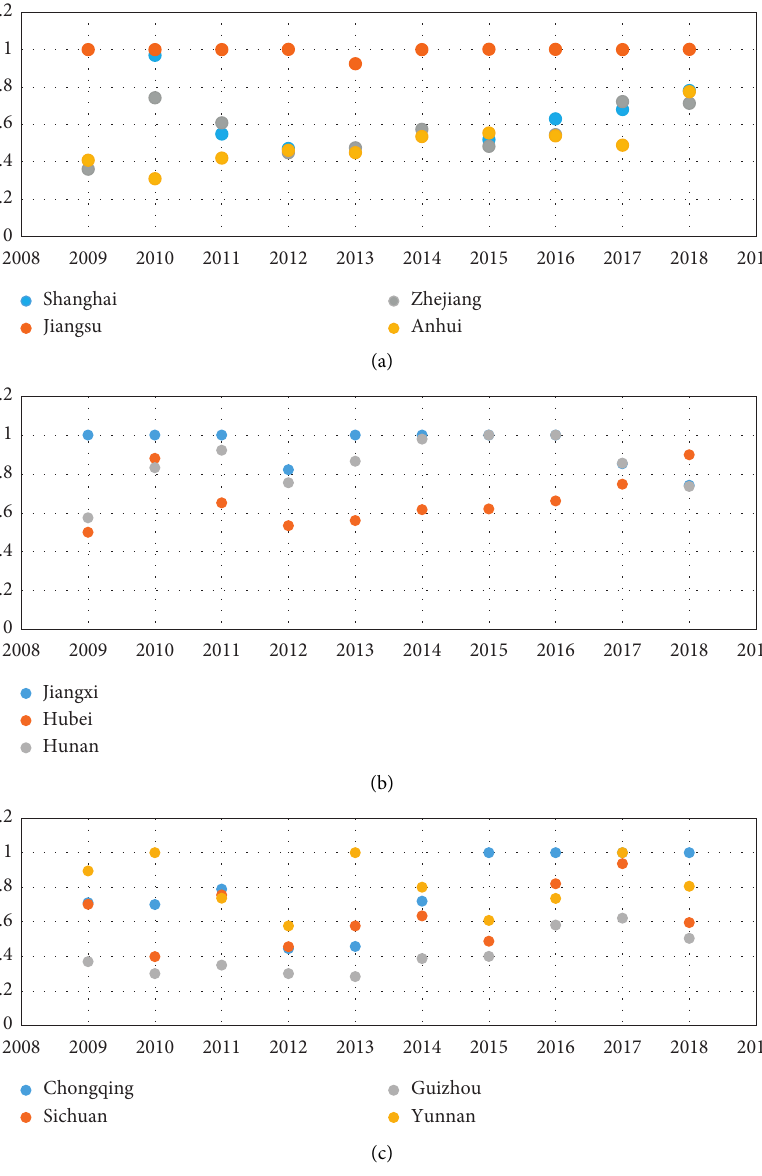
Figure 4: Efficiency of the high-tech industry in the technological marketization stage (2009–2018). (a) Stage2 of Yangtze River Delta. (b) Stage2 of the Middle Region. (c) Stage2 of the Western Region. Source: calculated by National Bureau of Statistics of China (NBSC), Statistical Yearbook of China’s High Technology Industry, Beijing: China Statistics Press,